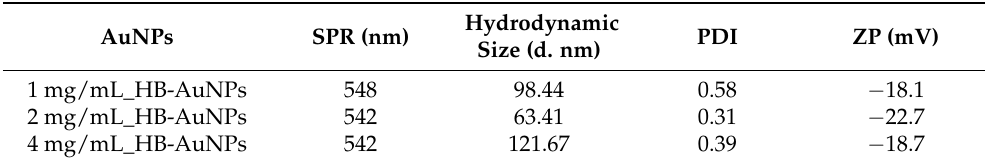
Table 1. Optical and DLS analysis of the HB-AuNPs synthesized at various HBE concentrations at 70 ◦ C.